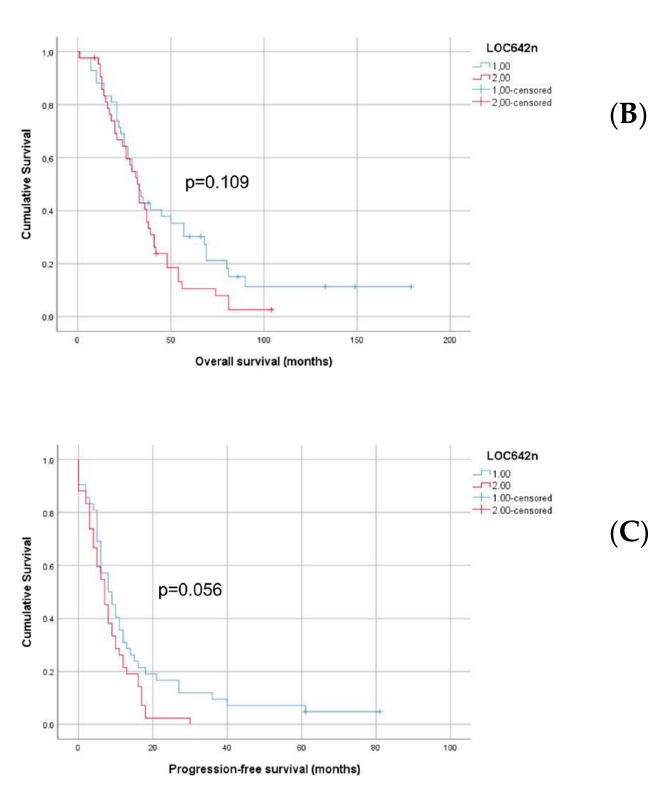
Figure 4. Anatomic site-related expression and Survival analysis ( A ) LOC642852 is overexpressed in the ovarian tumors (marked ‘2 ′ ) and solid metastases (marked ‘3 ′ ) compared to effusion specimens (marked ‘1 ′ ; p = 0.013) * -value of individual samples ( B ) Kaplan-Meier survival curve showing the association between LOC642852 expression level and overall survival (OS) for 85 patients with HGSC effusions. Patients with effusions with higher-than-median LOC642852 expression level ( n = 43; red line) had mean OS of 35 months compared to 53 months for patients with effusions having lower-than-median expression level ( n = 43, blue line; p = 0.109). ( C ) Kaplan–Meier survival curve showing the association between LOC642852 expression level and progression-free survival (PFS) for 84 patients with HGSC effusions (one patient with missing PFS data). Patients with effusions with higher-than-median LOC642852 expression level ( n = 42; red line) had mean PFS of 15 months compared to 8 months for patients with effusions having lower-than-median expression level ( n = 42, blue line; p = 0.056).